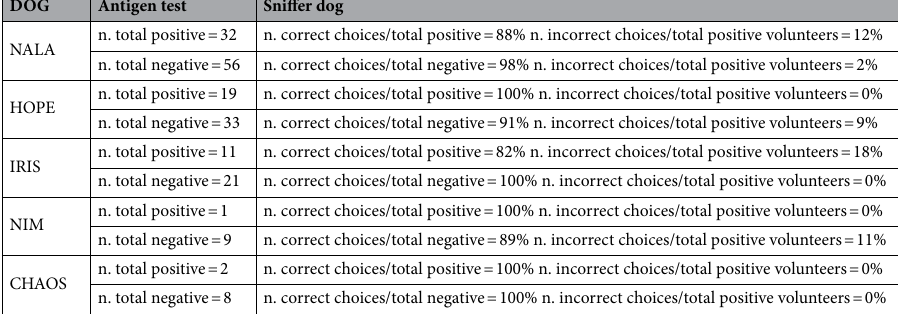
Table 7. Training of sniffer dogs for field work on